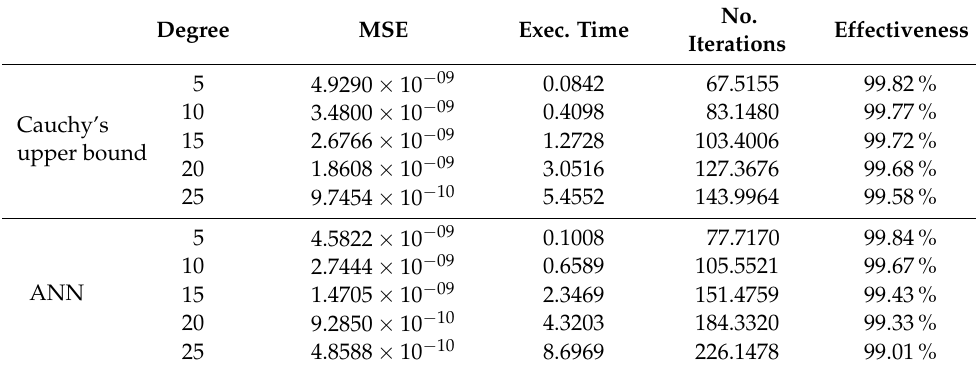
No. Effectiveness Iterations